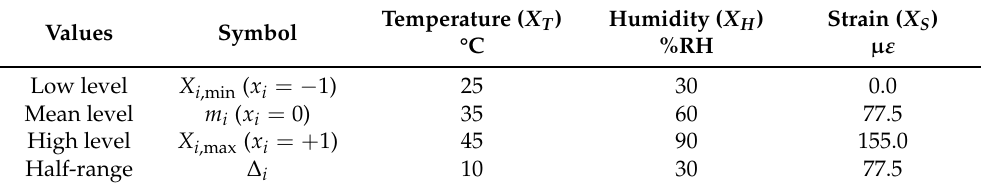
Table 1. The levels of temperature, humidity and strain used in DoE.